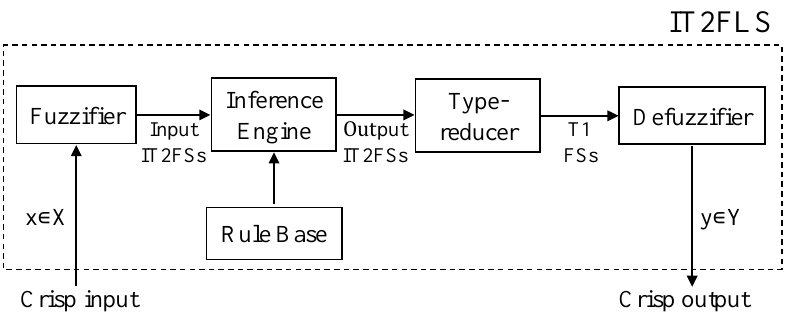
Figure 9. Structure diagram of an IT2FLS.